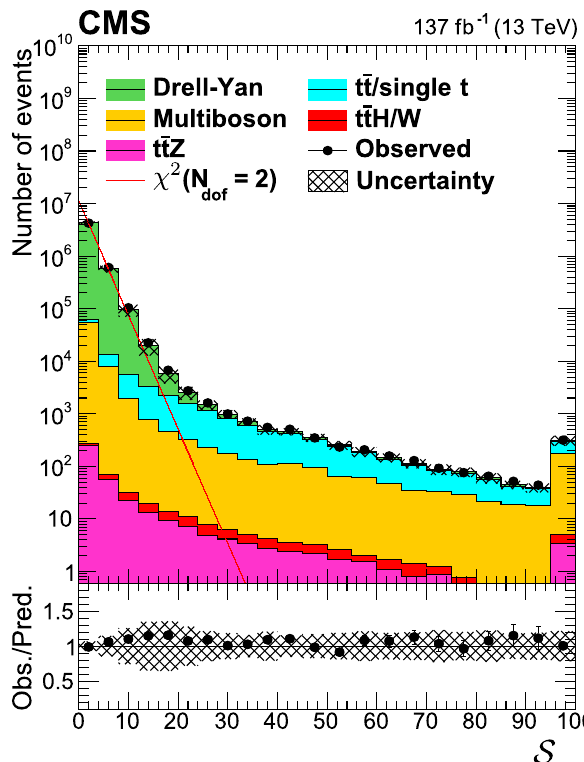
Fig. 2 Distribution of p miss significance S in a Z → (cid:5)(cid:5) selection, T requiring an SF lepton pair. Points with error bars represent the data, and the stacked histograms the SM backgrounds predicted as described inSect.6,withuncertaintyintheSMpredictionindicatedbythehatched area. The red line represents a χ 2 distribution with two degrees of free- dom. The last bin includes the overflow events. The lower panel gives the ratio between the observation and the predicted SM backgrounds. The relative uncertainty in the SM background prediction is shown as a hatched band